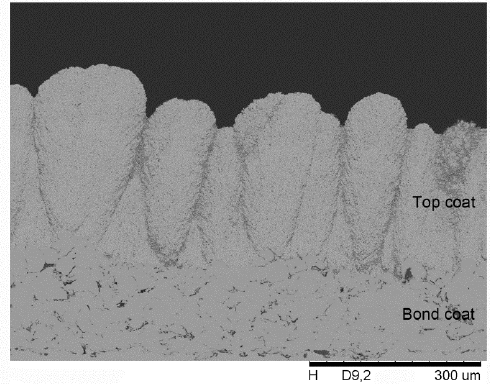
Figure 5. Cross-section image of the as-sprayed YSZ top coat (Sample J) deposited at a 70 mm standoff Figure 5. Cross ‐ section image of the as ‐ sprayed YSZ top coat (Sample J) deposited at a 70 mm standoff distance with 84 KW input power on as-sprayed BC. distance with 84 KW input power on as ‐ sprayed BC.